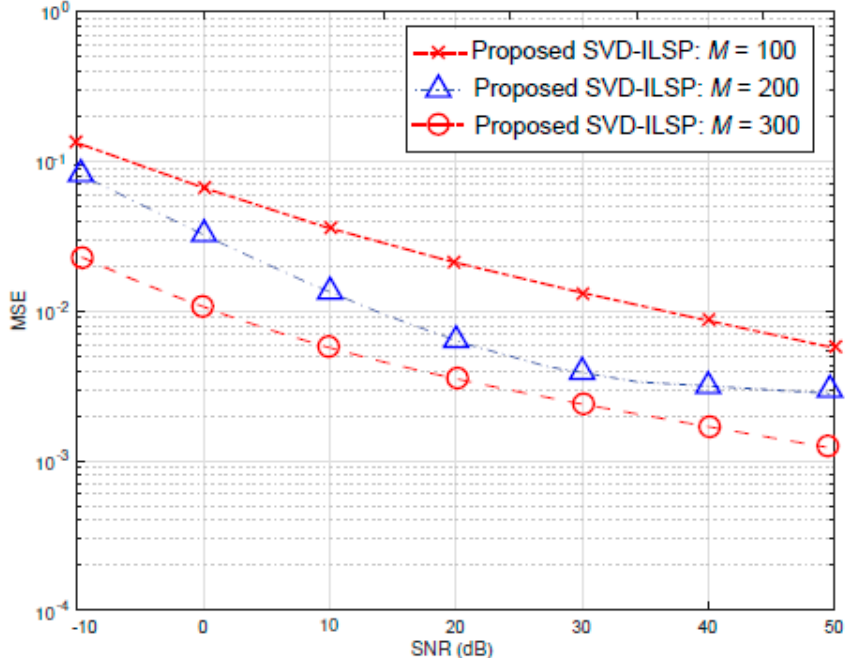
Figure 4. MSE comparison of the proposed joint channel estimation algorithm under different number of base station antennas.